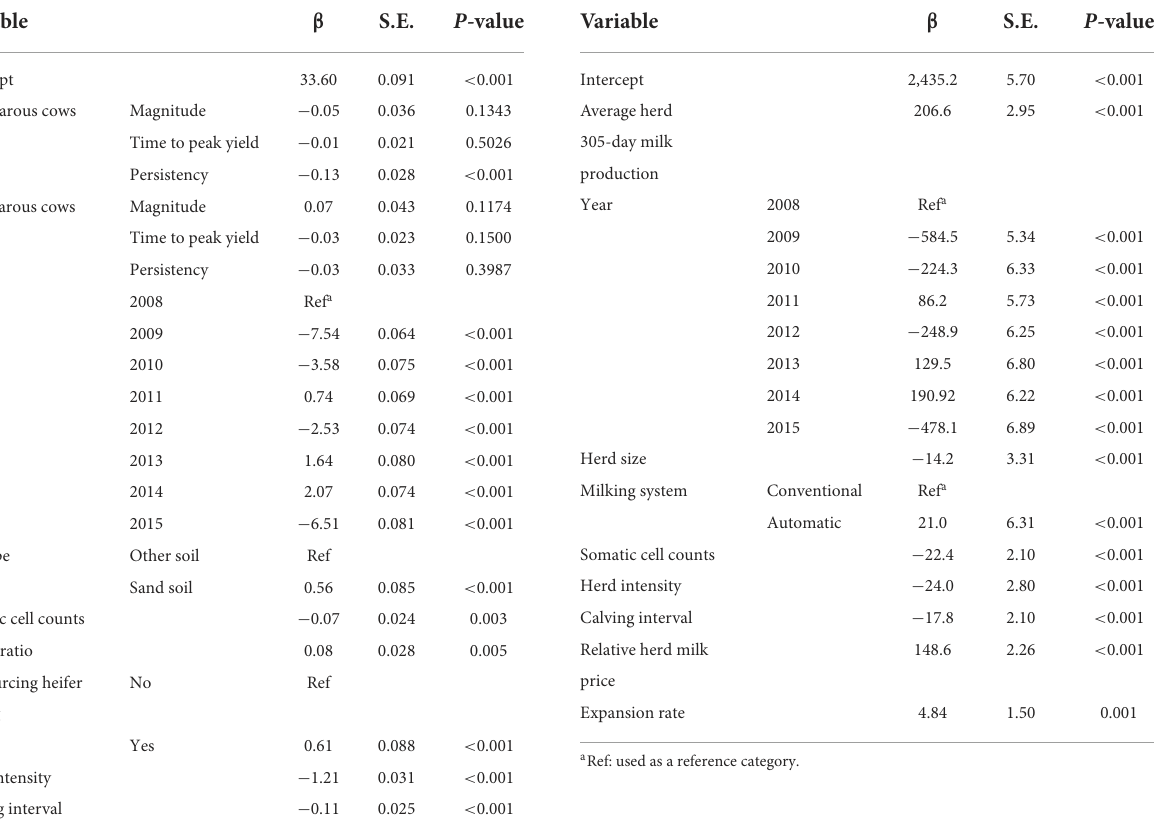
TABLE 3 Results of the final reduced linear mixed model on the association between income over feed cost per 100kg milk ( e ) and herd lactation curve characteristics (and other herd variables) based on data from 1,664 Dutch herds.